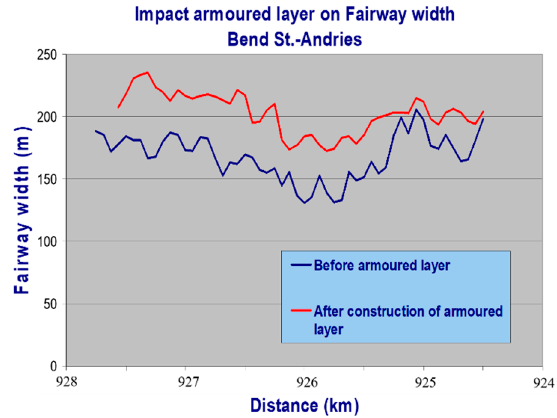
Figure 16. Increased navigation channel width at the St. Andries bend by fixed layer (at a depth of 2.5 m at ALW) (copyright RWS).